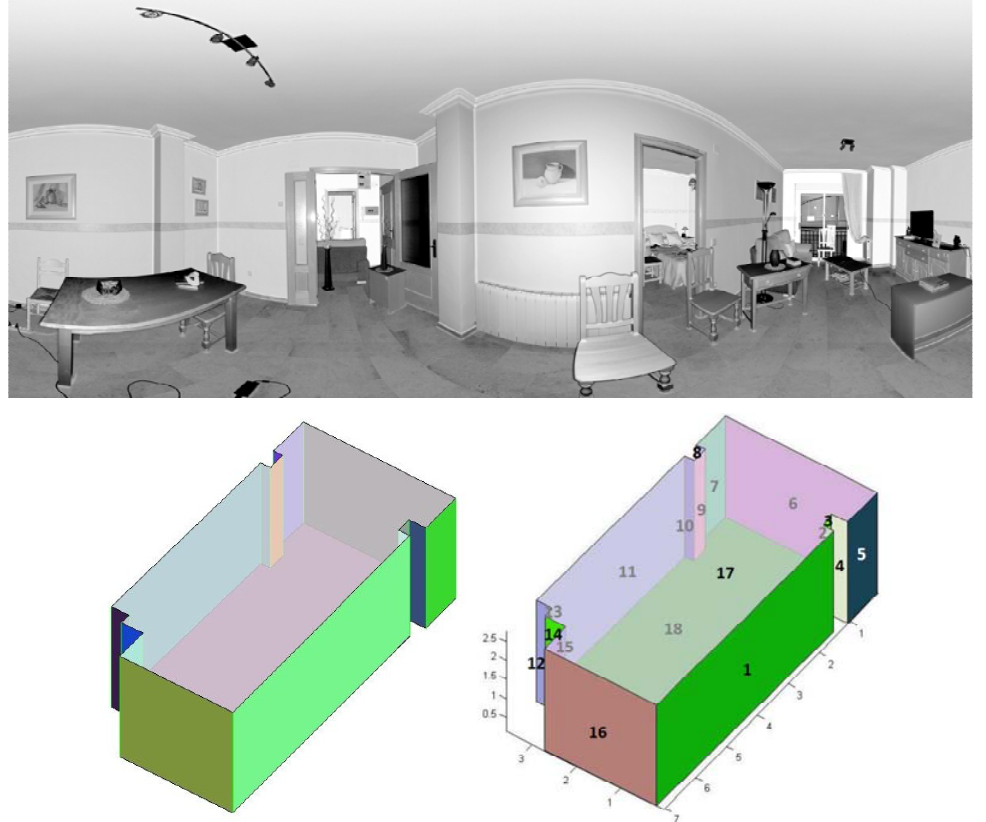
Figure 8. Planar image of the living room ( top ). Our model and the ground truth model ( bottom